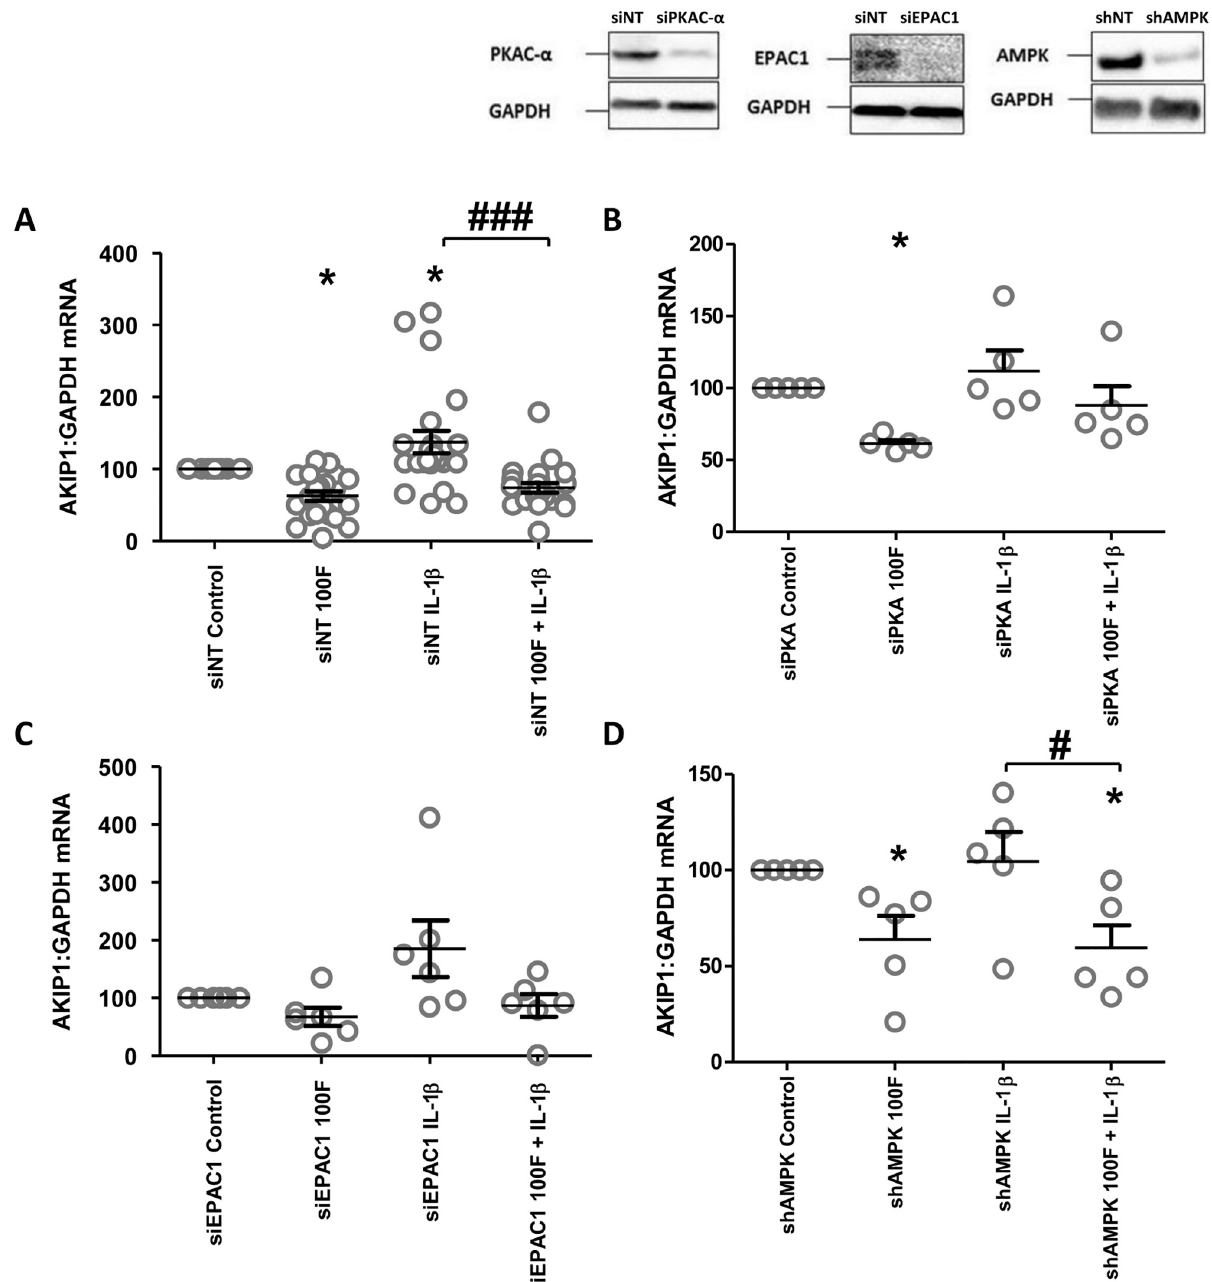
Fig 7. The effect of cAMP effector knockdown on the ability of cAMP in mediating IL-1 β -induced AKIP1 mRNA expression. 96 hours post transfection with control siRNA (siNT) (A), PKAc- α siRNA (siPKAc- α ) (B), EPAC1 siRNA (siEPAC1) (C), and AMPK siRNA (siAMPK) (D) myometrial cells were treated with IL-1 β (1ng/mL) and/or forskolin (100 μ M) either alone or in combination for 6h as described in Materials and Methods and the levels of AKIP1 mRNA were measured using rt-PCR. Data are shown as the mean and SEM ( � P < 0.05, �� P < 0.01, ��� P < 0.001 when compared to control, #P < 0.05, ##P < 0.01, ###P < 0.001 when IL-1 β is compared to 100F + IL-1 β ), n = 6. Representative western blots to demonstrate transfection efficiency are shown.